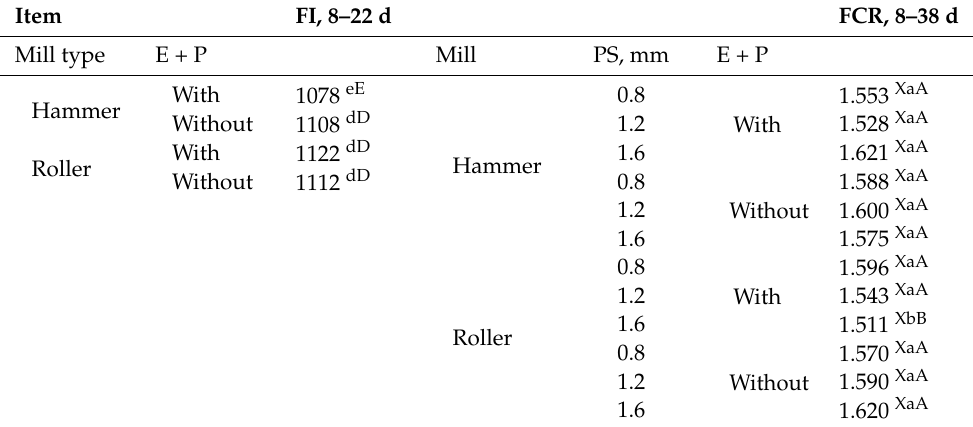
Table 6. Breakdown of significant interactions as presented in Table 5.